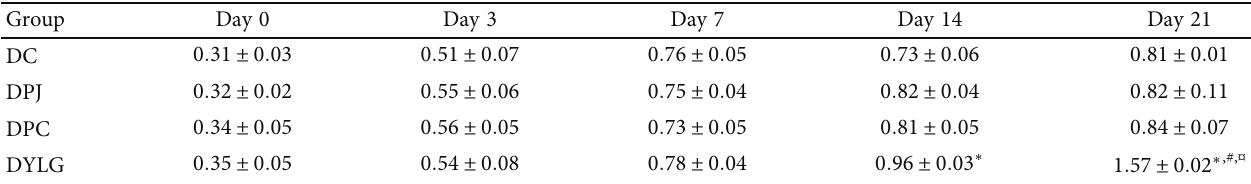
Table 3: The blood insulin levels (ng/ml) in T2DM rats on days 0, 3, 7, 14, and 21 ( n = 24 per group).